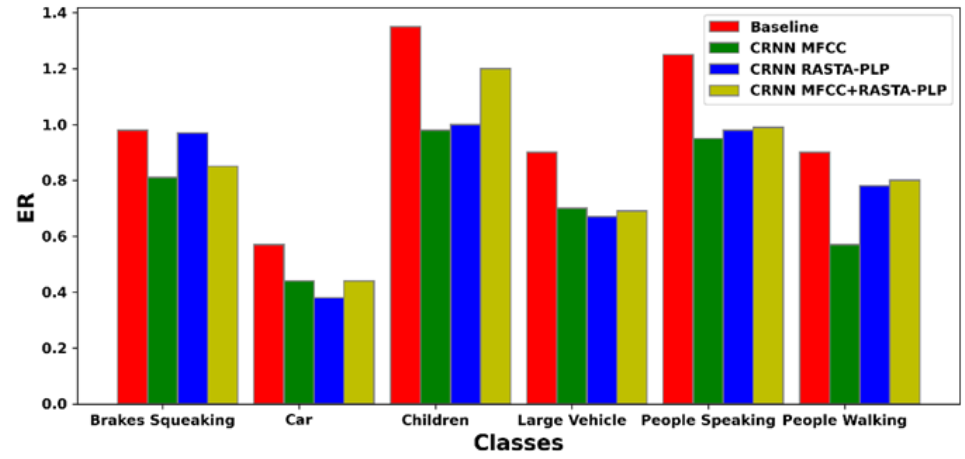
Figure 7. ER comparison using CRNN classifier.